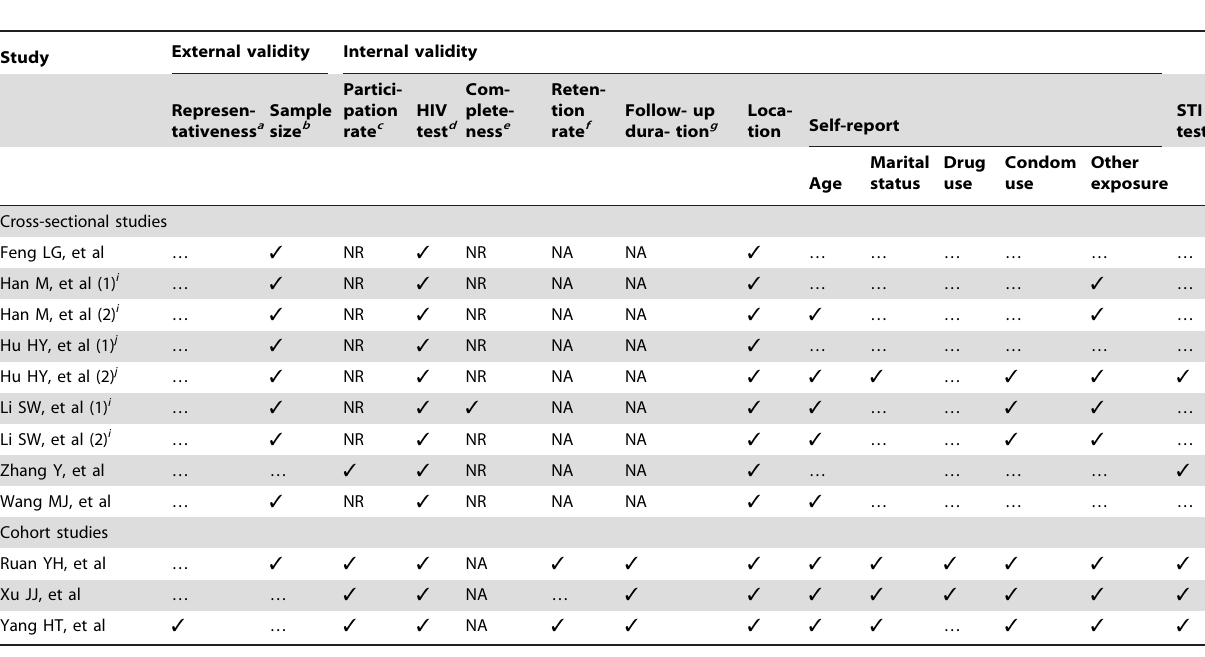
Table 2. Quality assessment of the studies included in